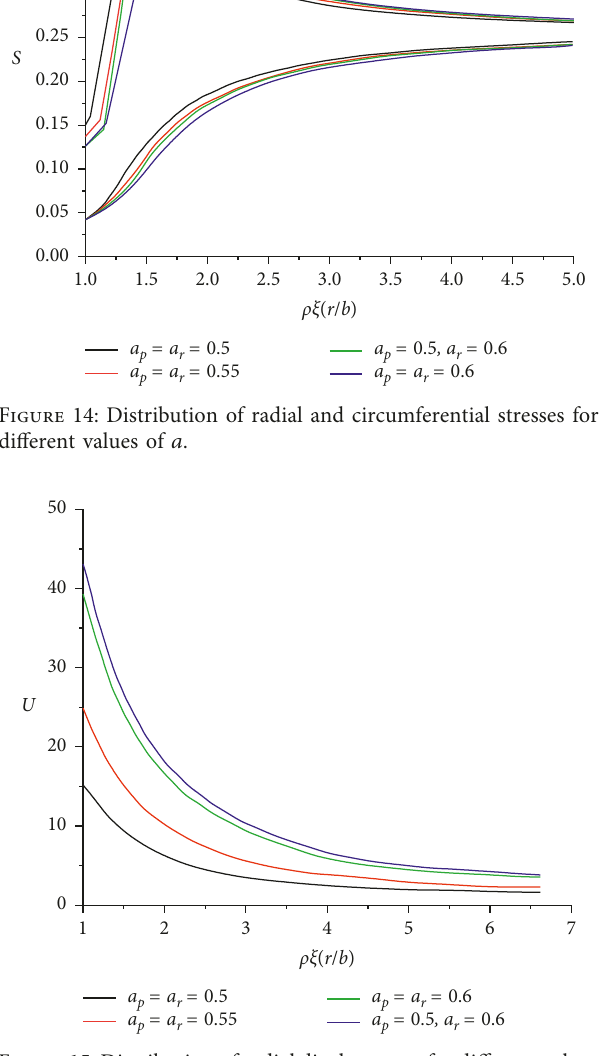
Figure 13: Variation of the dimensionless radial displacement with based on the M-C rock mass. the change of c p ∗